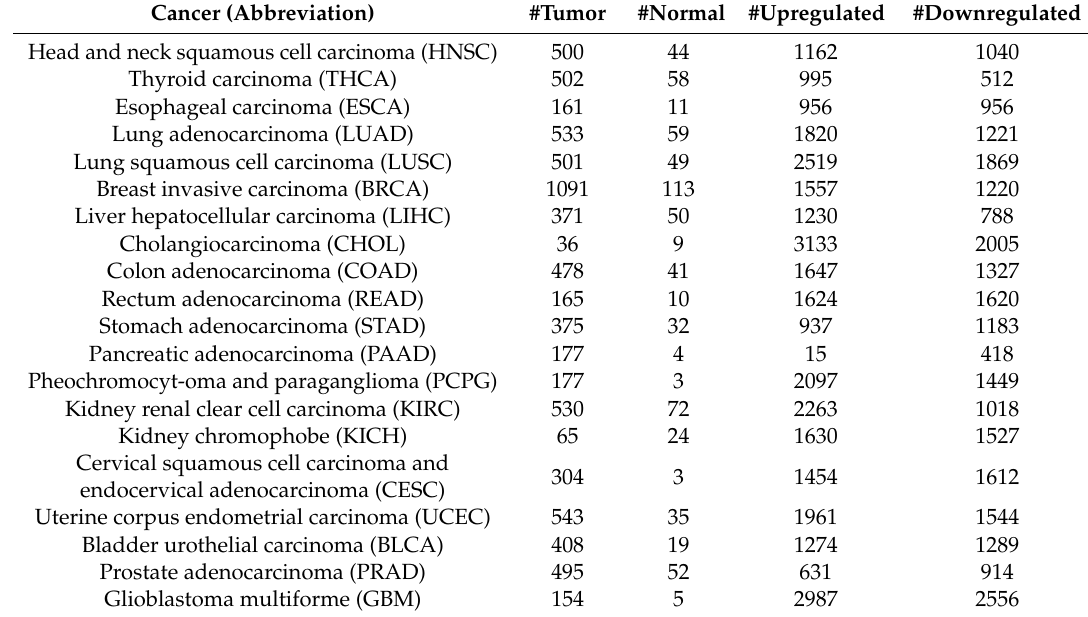
Table 1. Sample size and number of di ff erentially expressed genes for 20 cancers in the Cancer Genome Atlas